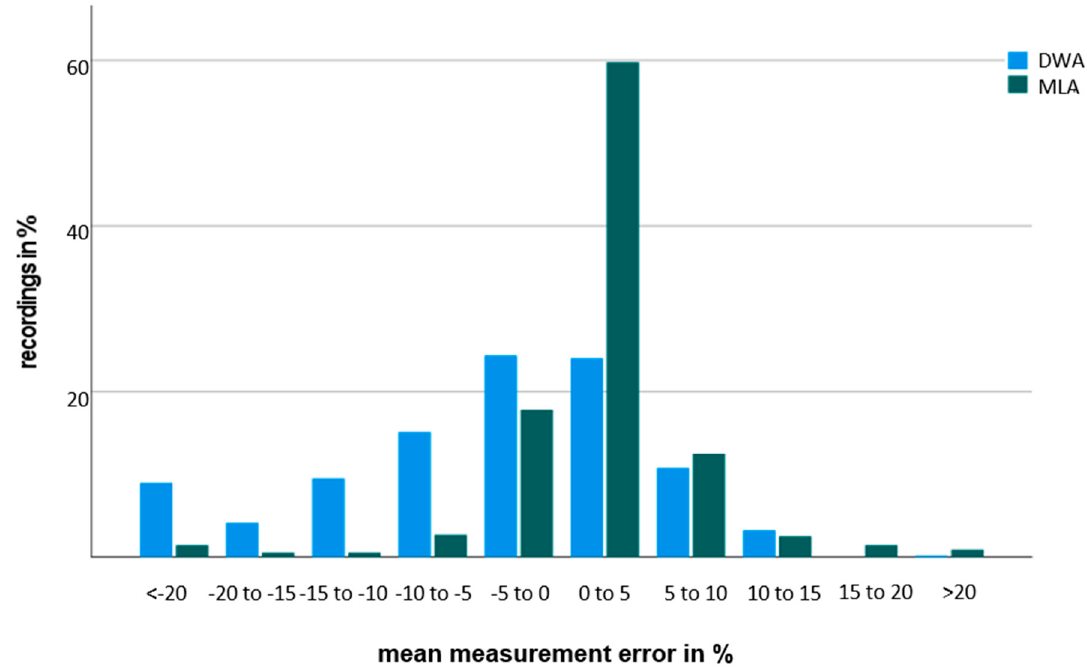
Figure 7. Histogram of the relative frequencies of relative measurement errors for the Digiwalk algorithm (DWA) and the Mobility Lab algorithm (MLA) compared to the current gold-standard odometer.